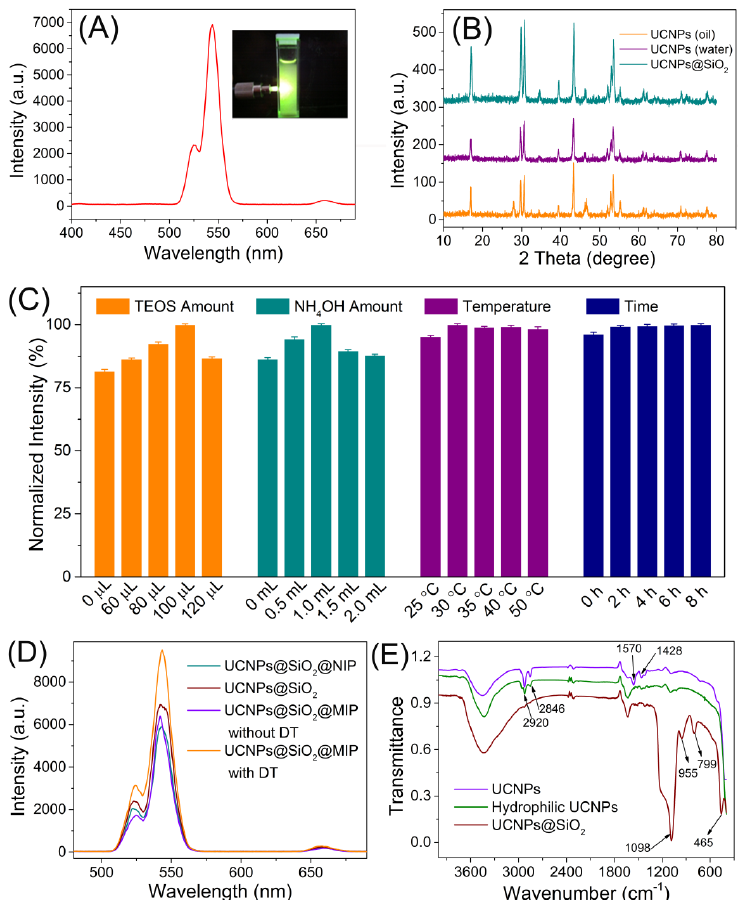
Figure 2. ( A ) Upconversion luminescence spectra of the as-prepared β -NaYF 4 : Yb 3+ , Er 3+ nanocrystals with inset as the typical photograph of the UCNPs under excitation; ( B ) The XRD patterns of the UCNPs powders: hydrophobic UCNPs (green), hydrophilic UCNPs (purple), and UCNPs@SiO 2 (orange); ( C ) Optimization of the silica coating procedures: Tetraethylortosilicate (TEOS) amount (orange), NH 4 OH amount (teal), reaction temperature (purple), and reaction time (blue). ( D ) Comparison of the fluorescence intensity of different polymeric materials; ( E ) The FT-IR spectra of the UCNPs and UCNPs@SiO 2 .